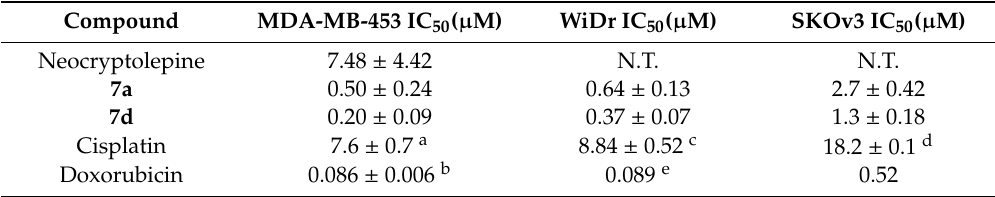
Table 3. Antiproliferative activity of neocryptolepine derivatives against cell lines of the breast